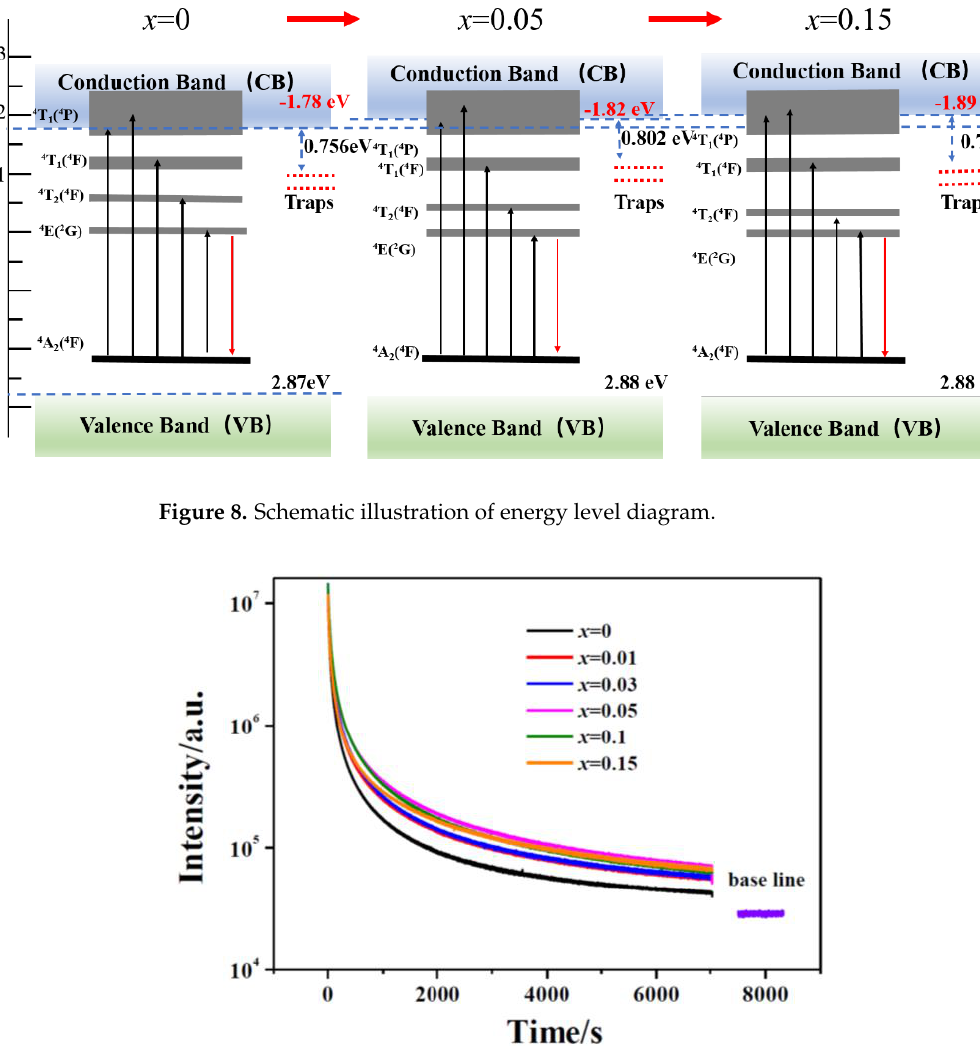
Figure 9. NIR persistent luminescence decay curves of ZGMSO:Cr 3+ ( x = 0 – 0.15).